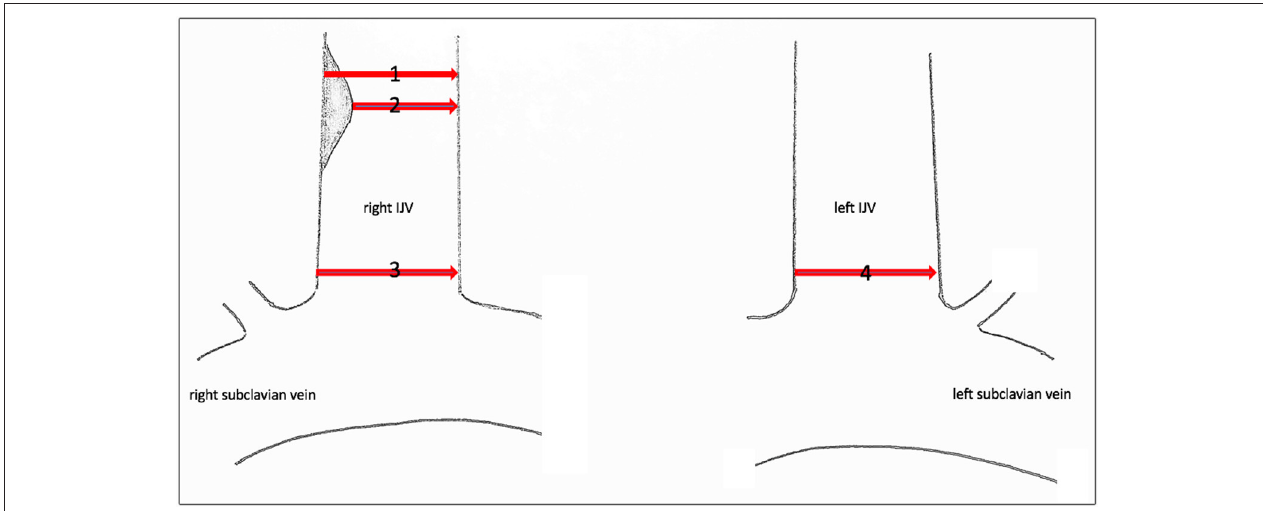
FIGURE 1 | Sonographic measuring points of the IJV. Sonographic measuring points of the IJV to determine the grade of stenosis or dilatation. (1) Local diameter at the former catheter’s entry site. (2) Residual diameter. The grade of stenosis caused by the endothelial lesion is calculated according to the ECST by the percentage diameter reduction. (3) Proximal dimension at the level of C7. The percentage of stenosis/dilatation is calculated relative to the diameter of the contralateral IJV, diameter 4, according to the NASCET.